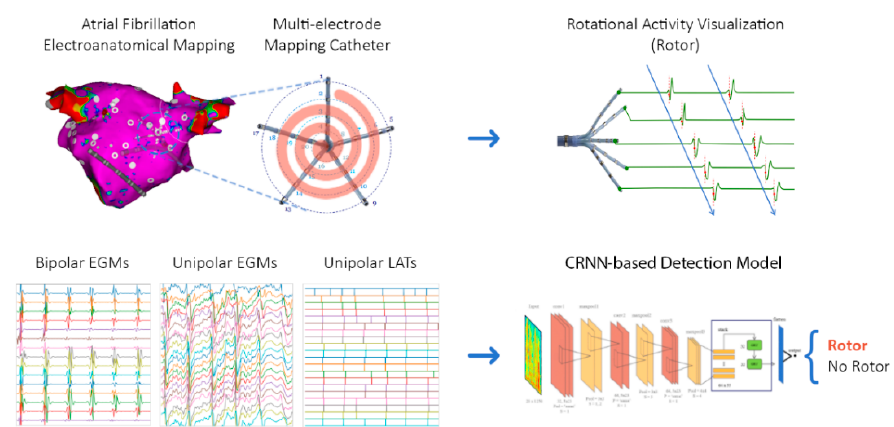
Figure 1. CNN-based rotational activity detection workflow. ( Top ) Endocardial EGMs registered with a multi-electrode catheter exhibiting a rotational activation (rotor) staircase pattern. Signals were obtained from a 3D electroanatomical mapping system and multi-electrode catheters. ( Bottom ) Bipolar EGMs, unipolar EGMs, and unipolar LATs are used as input signals and are fed to the proposed CRNN-based model to train and detect the presence of rotational activity in AF endocardial signals. EGMs, electrograms; LATs, local activation times; CRNN, convolutional recurrent neural network.